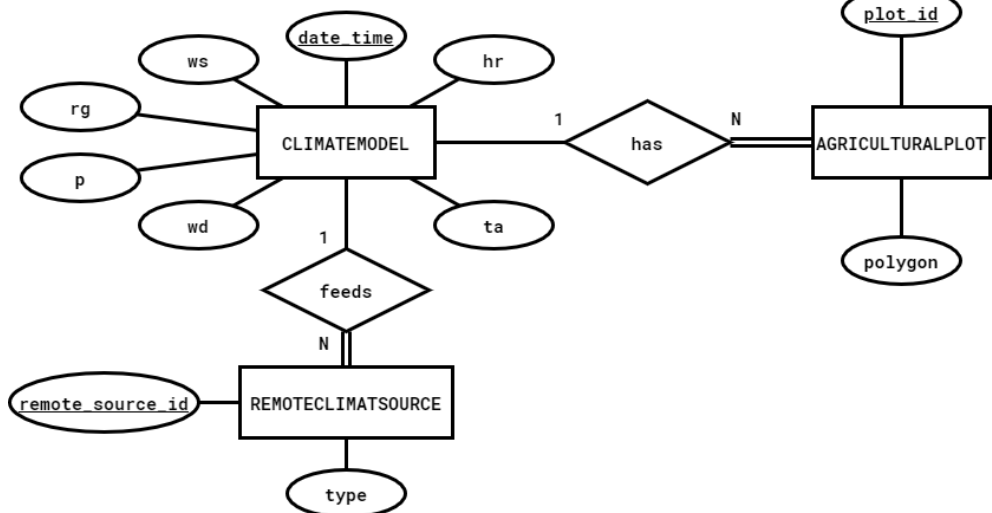
Figure 4. The Entity Relationship Diagram used in the climate database design; ta: air temperature (R3_Tair), rg: global solar radiation (R3_Rg), hr: air relative humidity (R3_Hr), p: rainfall (R3_P), ws: wind speed (R3_Vv), wd: wind direction